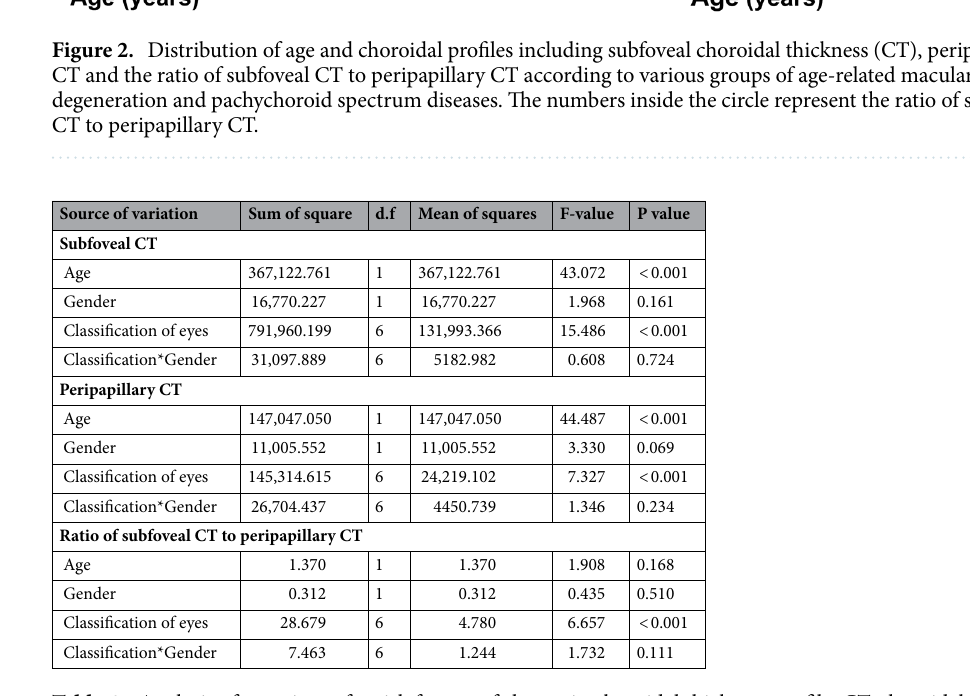
Table 4. Analysis of covariance for risk factors of change in choroidal thickness profile. CT, choroidal thickness.